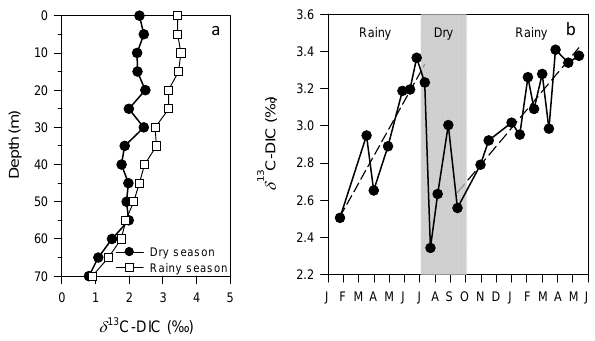
Figure 2. Depth profile of the δ 13 C of the dissolved inorganic car- bon (DIC) pool in the mixolimnion during the dry (18 July 2012) and the rainy (20 March 2013) season and (b) temporal variation of the δ 13 C-DIC in the mixed layer of Lake Kivu between January 2012 and June